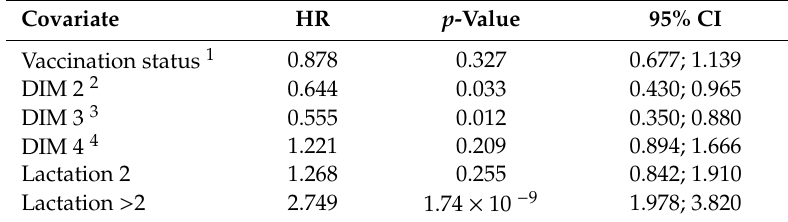
Table 2. Multivariable Cox regression analysis results in 73 dairy cattle farms in Israel. Event is defined as in-farm death or urgent